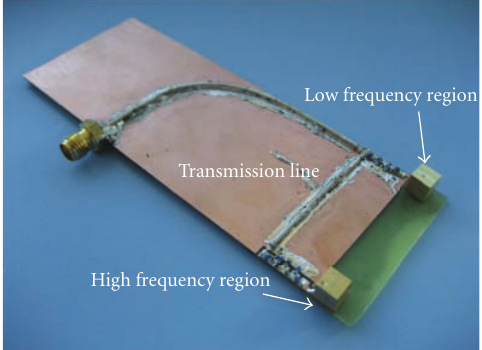
F 33: Pentaband prototype designed including the reactance cancellation inductor, the broadband matching network, and the notch �lters required for providing isolation between both fre- quency